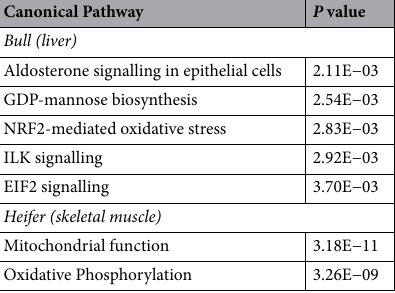
Table 7. Canonical pathways derived from IPA analysis associated with divergence for RFI in bull hepatic tissue and heifer skeletal muscle